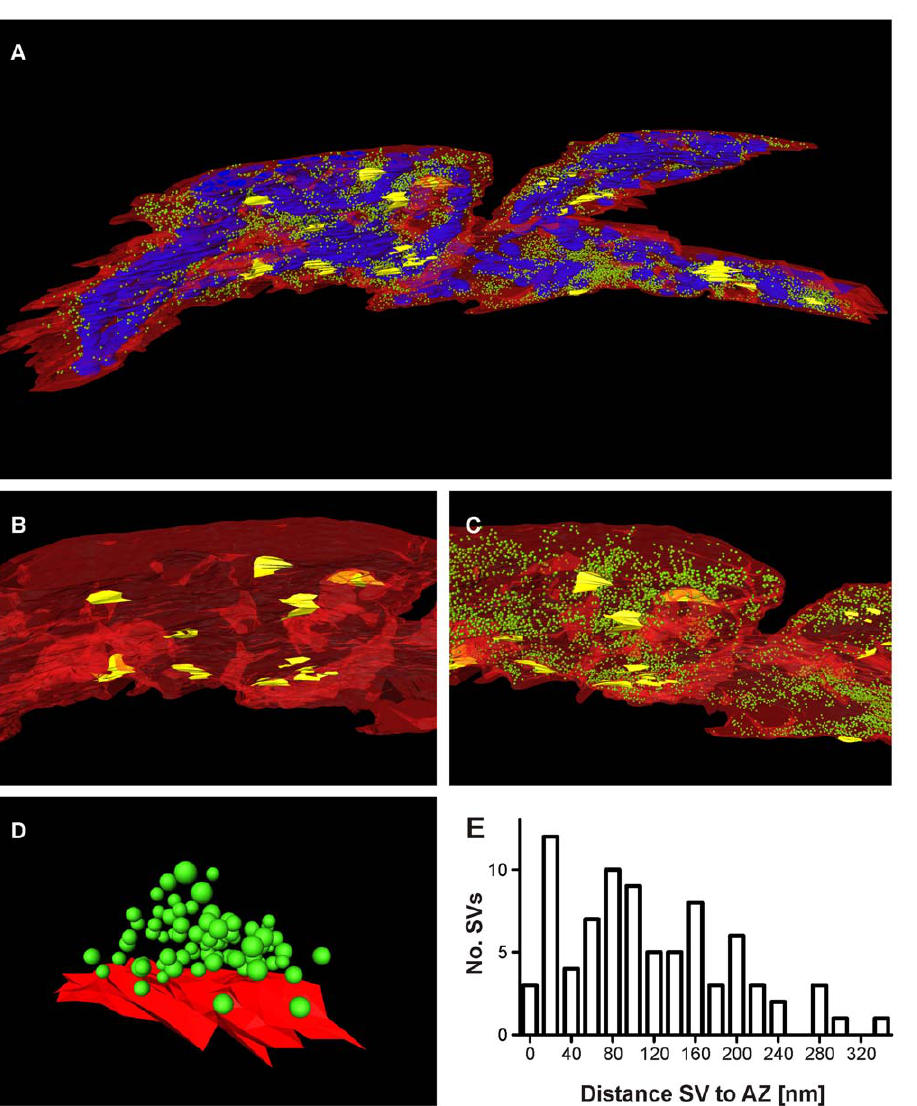
Figure 5. 3D reconstruction of a calyx of Held segment based on SEM images obtained from 100 consecutive sections. A: Full reconstruction of a 31.7 m m 3 calyx segment. The innervation side is orientated to the front. Red: plasma membrane; yellow: postsynaptic densities; blue: mitochondria; green: synaptic vesicles. B: Close up showing only plasma membrane and postsynaptic densities (colours as in A ). C: Close up showing plasma membrane, postsynaptic densities and synaptic vesicles (colours as in A ). D: 3D reconstruction of a single release site (colours as in A ). E: Histogram of the distribution of distances between the presynaptic membrane and the synaptic vesicle membranes based on the release site shown in D .